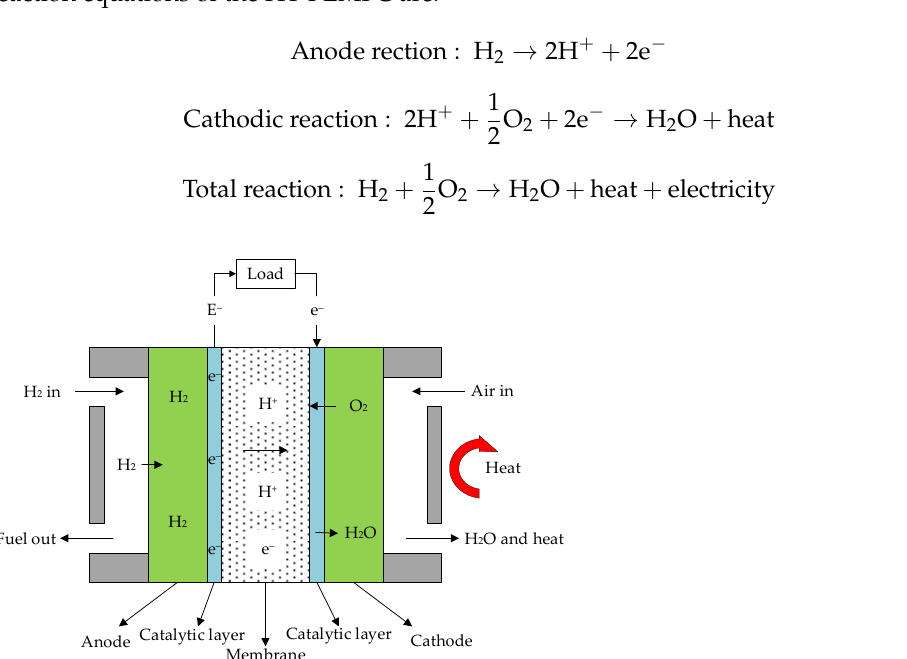
Figure 1. Working principle of high-temperature proton exchange membrane fuel cell (HT-PEMFC).